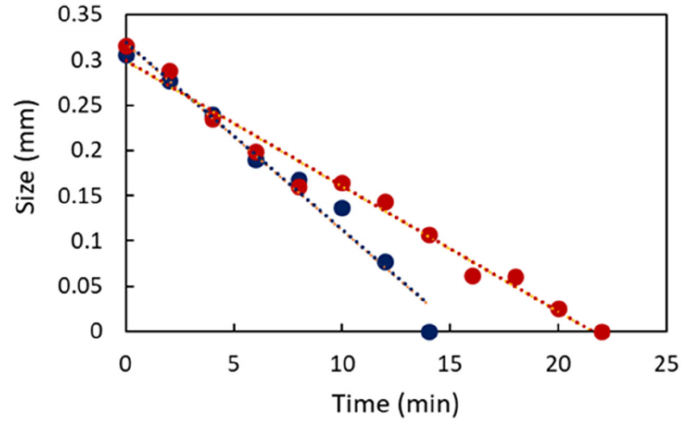
Figure 3. Dissolution of form II crystals in the presence (1.0% ( w / v )) and absence of agarose. The average crystal widths as a function of time. Blue and red circles represent the crystals in the absence and presence (1.0% ( w / v )) of agarose,